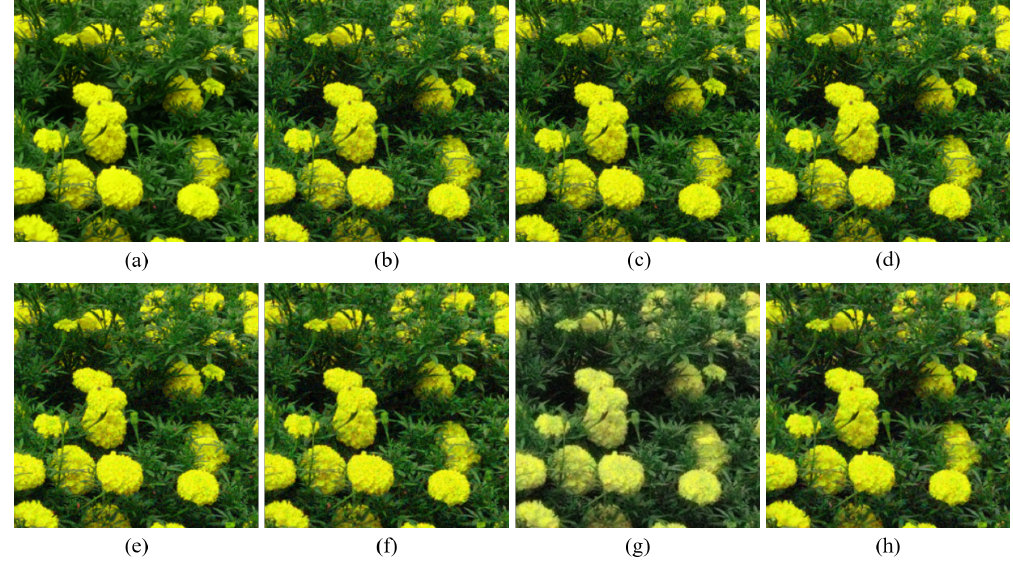
Figure 14. Demosaicing results of the McMaster No. 16 image under high-noise condition. ( a ) Original